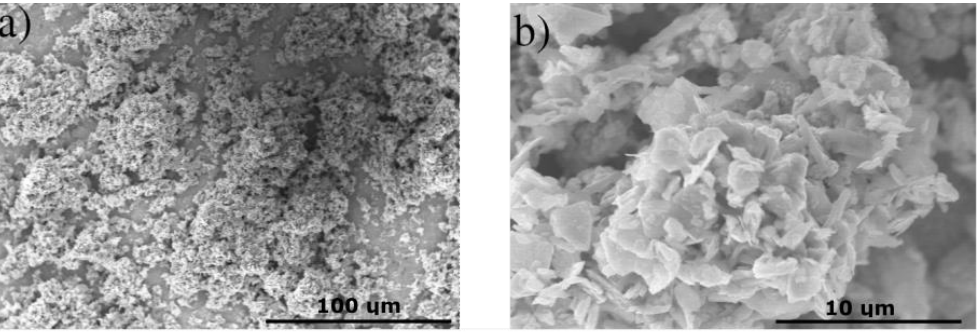
Figure 6. SEM micrograph of a Cu–MoS 2 composite coating on a carbon steel N80 substrate, ( b ) SEM micrograph of the coating in ( a ) with higher magnification.